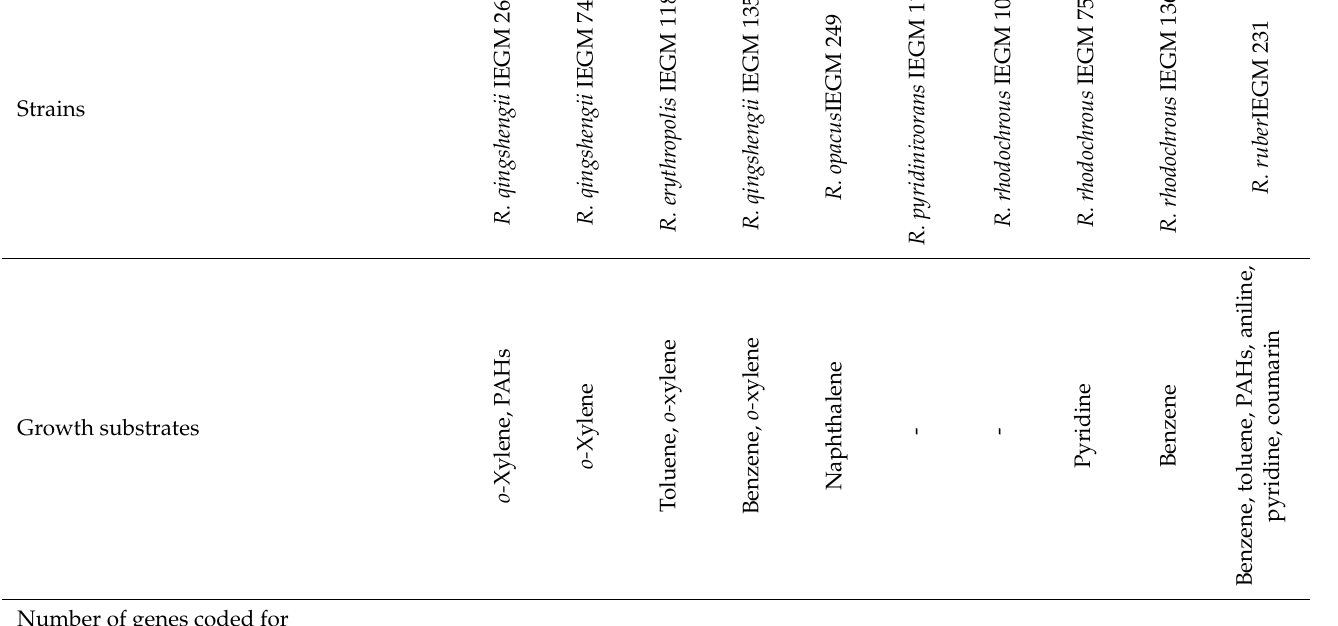
Table 3. Numbers of genes coded for putative enzymes of aromatic compound biodegradation by Rhodococcus